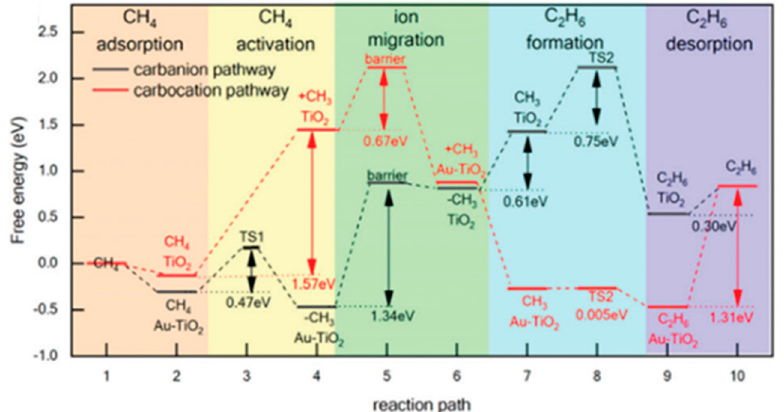
Figure 48. DFT calculation of the free energy of the carbanion pathway and the carbocation path- way. Reproduced from [28] with permission from The Royal Society of Chemistry. DFT: Density function theory.